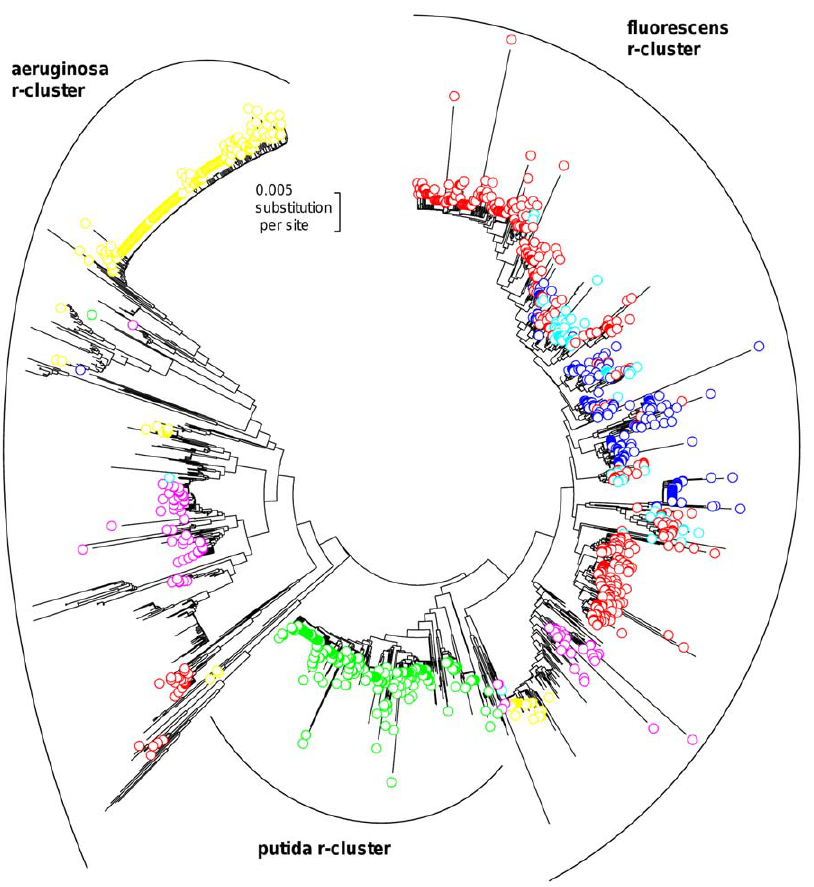
Figure 4. Phylogenetic occurrence of the major V1 hypervariable motifs. The phylogenetic tree was built from 1803 full-length 16S rRNA sequences of Pseudomonas available in the databases, after excluding the V1 region (see Figure S7). Each colour corresponds to a V1 motif (present in the original 16S rRNA sequence) found in at least two r-clusters. For the sake of visibility, only the six major V1 motifs (see Table 4) are shown, from the most represented (red circle), in this descending order: red, green, yellow, dark blue, purple, and light blue circles.